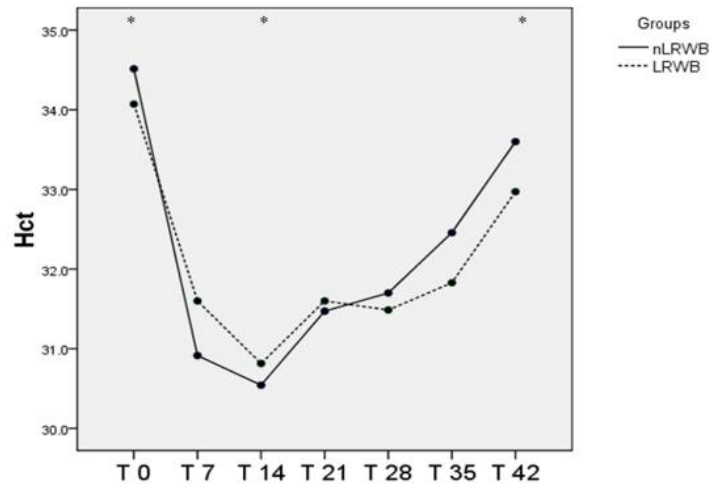
Figure 2. Differences in Hct (mean) measured in nLRWB and LRWB units during the storage period ( p < 0.05). The six weeks of storage are presented in the x-axis; the T0 corresponds with the day of